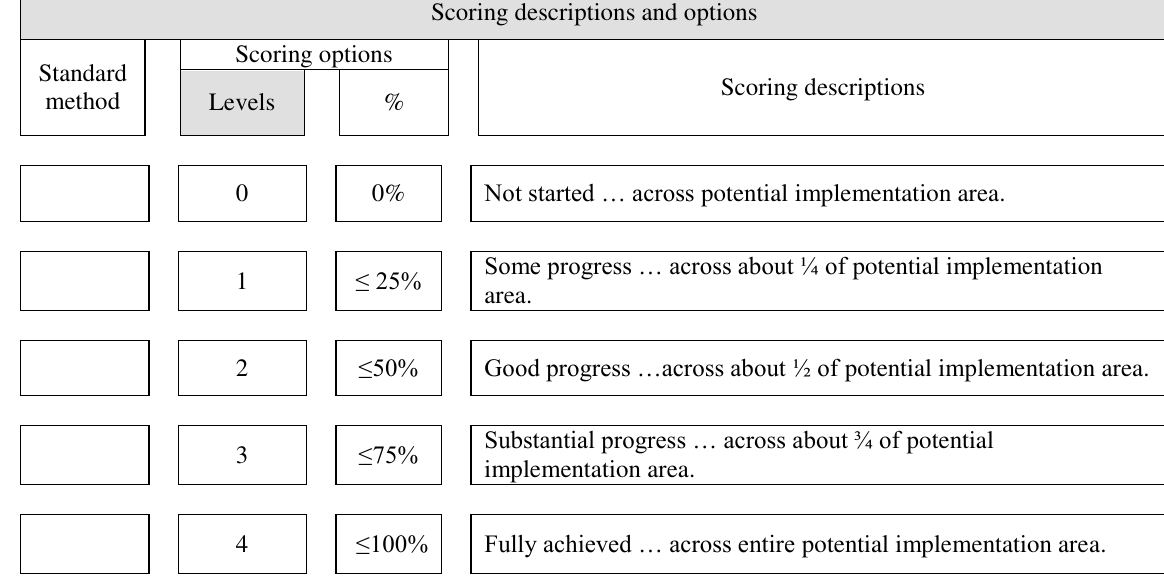
Fig. 2. Scoring description and options